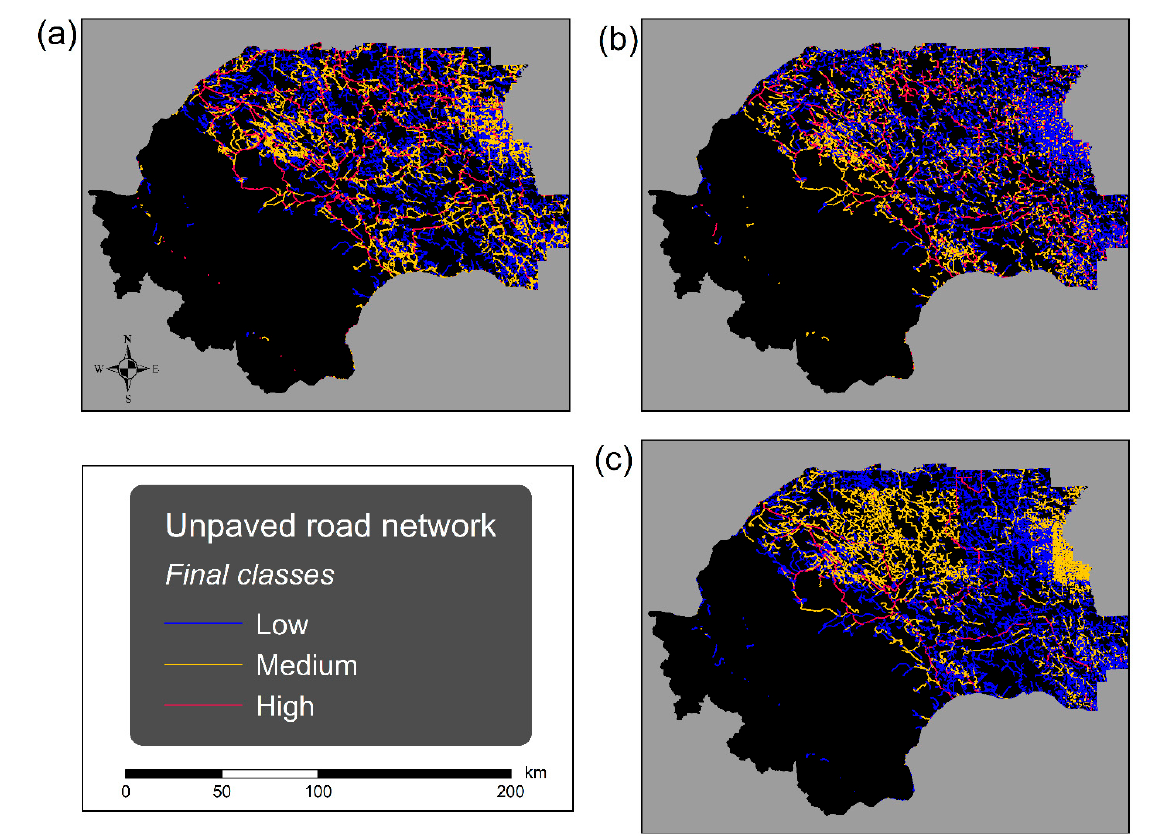
Figure 4. Map the final classifications for all unpaved roads for ( a ) the network-based method, using circuit theory to connect activity locations for recreation, oil and gas extraction and logging; ( b ) the image-based method using RapidEye satellite imagery trained with road surface roughness and travel speed collected from a mobile app; and ( c ) the reference classification derived from the Government of Alberta provincial database, where classes were defined as: high = “o-lane gravel roads”; medium = “one-lane gravel roads”; low = and all other unpaved road classes (“unimproved”,